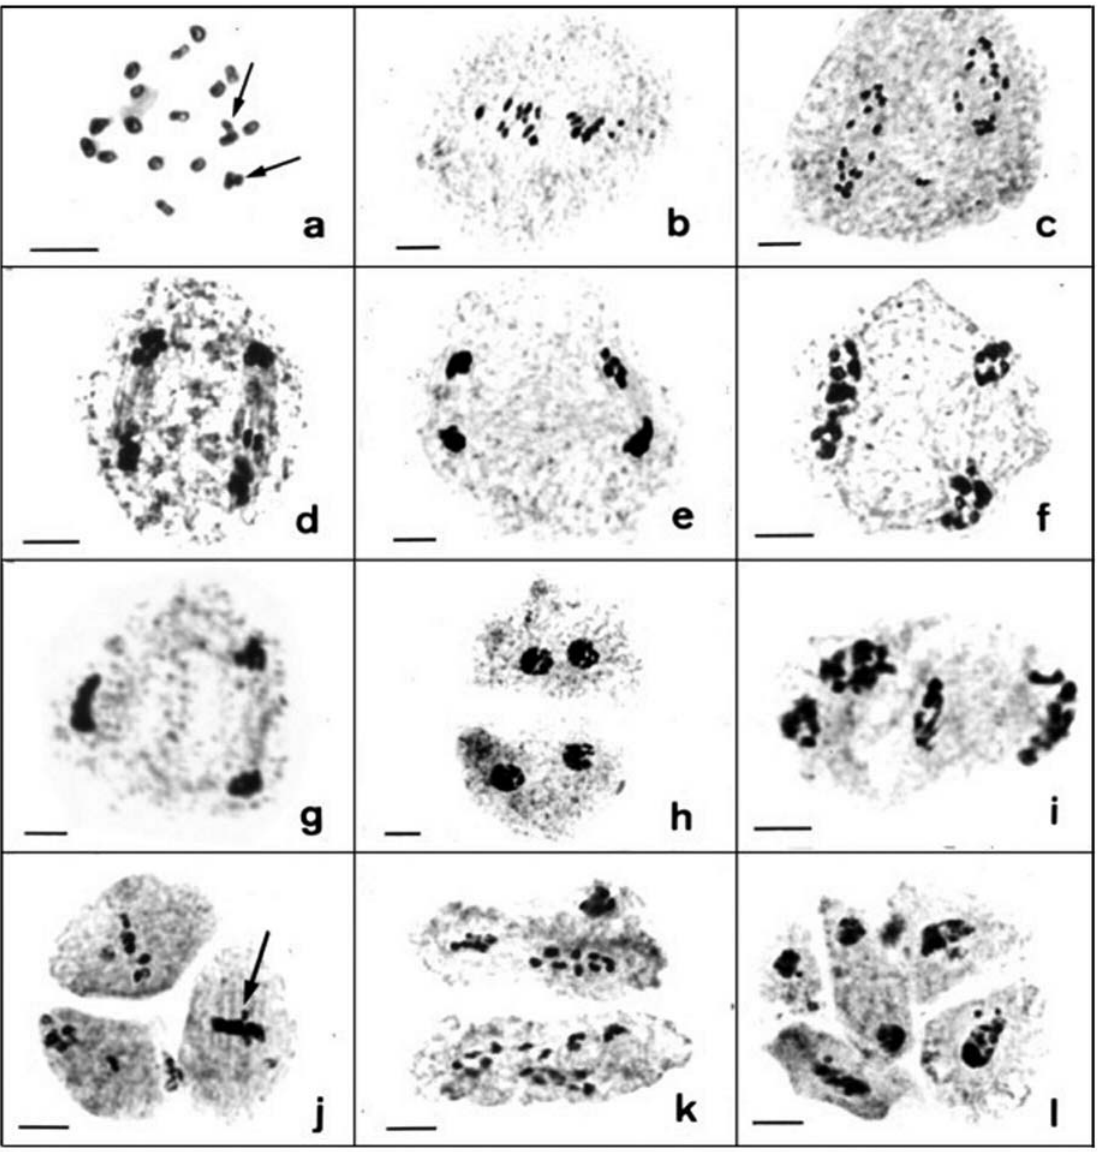
Figure 1 - Chromosome behavior during microsporogenesis in a hybrid between B. ruziziensis (R) and B. brizantha (B); (a) diakinesis with 17 II and 2 I (arrows); (b) metaphase I with B and R genomes arranged in two metaphase plates; (c, d) anaphase I with two distinct spindles (in c, note that nine chro- mosomes are migrating to the poles in each spindle); (e) telophase I with both genomes properly segregated; (f, g) trinucleate telophase I with only one segregated genome, the other remained non-segregated; (h, i) early and late prophase II with normal genome segregation; (j) late prophase II after normal chromosome segregation (the arrow indicates a cell with a restitution nucleus; (k) irregular chromosome distribution in anaphase II; (l) polyad with dif- ferently sized nuclei and microspores. (Bars = 1 (cid:2)